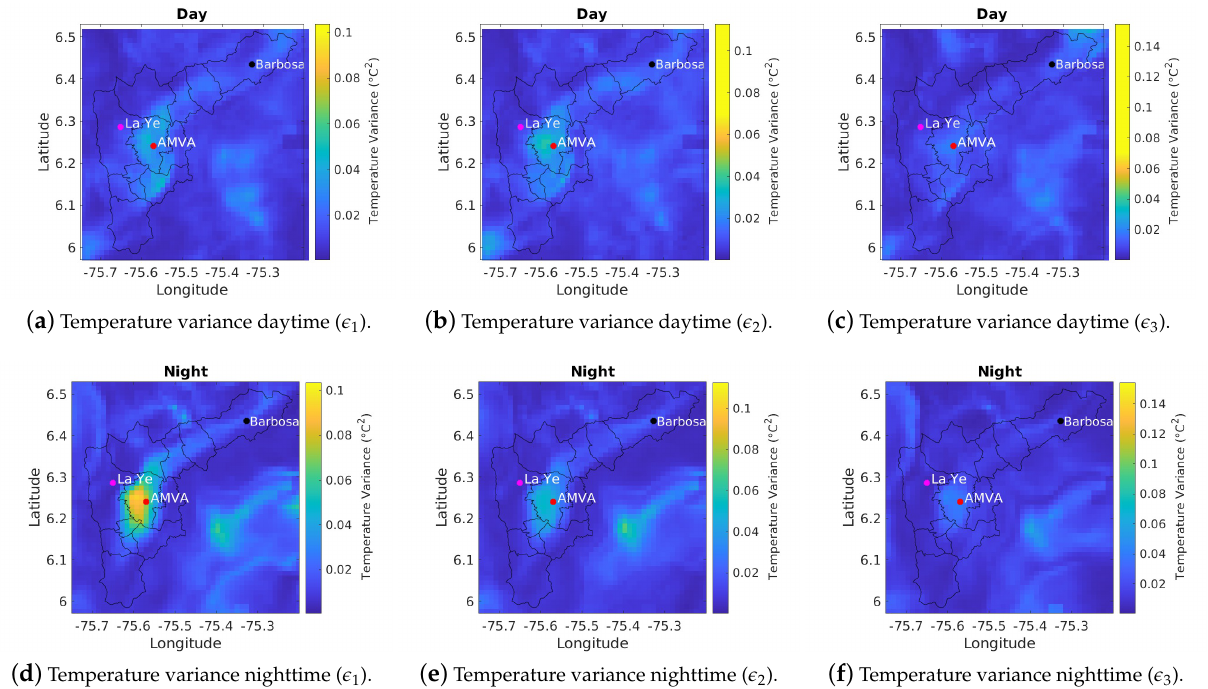
Figure 5. Average temperature variance for each kind of perturbation by using 100 ensembles. ( a ) Variance in the daytime for (cid:101) 1 . ( b ) Variance in the daytime for (cid:101) 2 . ( c ) Variance in the daytime for (cid:101) 3 . ( d ) Variance in the nighttime for (cid:101) 1 . ( e ) Variance in the nighttime for (cid:101) 2 . ( f ) Variance in the nighttime for (cid:101) 3